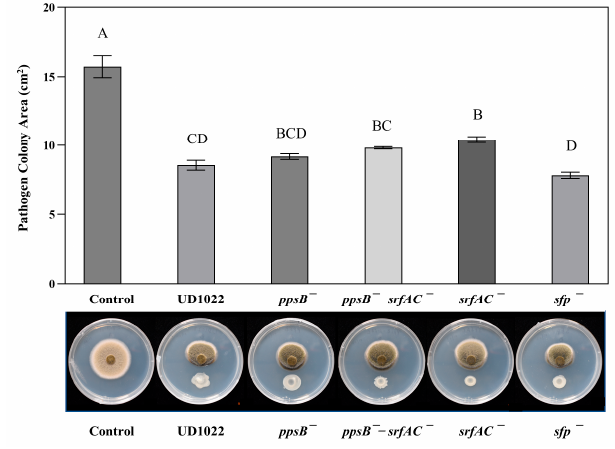
Figure 2. Results of antagonism assays with UD1022 mutants in key nonribosomal peptide (NRP) pathway genes against A. medicaginicola StC 306-5. Bars are the mean colony area ( n = 3) and standard error (SE) of the mean from one representative experiment of three experiments performed. UD1022 mutant treatment srfAC − was significantly less antagonistic than UD1022 ( p = 0.044). The antagonistic effects of mutants sfp − , ppsB − , ppsB − - srfAC − were no different from UD1022. Colony areas of StC 306-5 challenged by UD1022 biofilm mutants sinI − or eps − - tasA − were no different from the UD1022 control treatment, remaining antagonistic. Antagonism of the StC 306-5 colony area was reduced to 5% when challenged by the spo0A − mutant and the colony area was not statistically different from the water control treatment ( p = 0.881) (Figure 3).